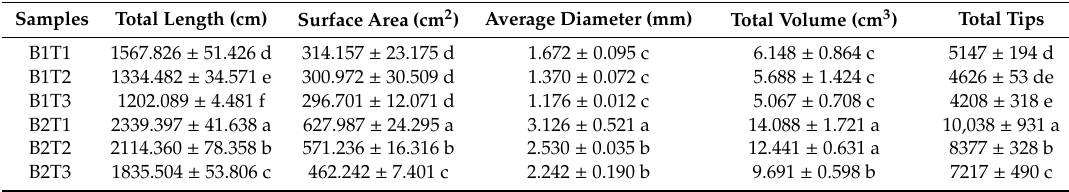
Table 2. The influence of di ff erent nutrient solution irrigation treatments and downy mildew infection on root systems parameters of cucumber